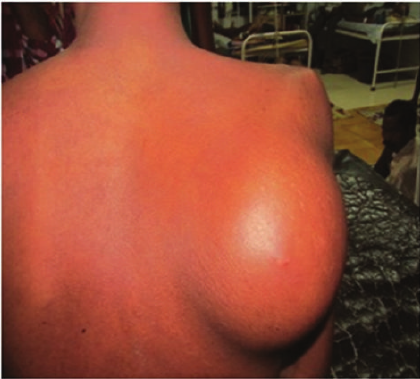
Figure 1: Clinical photograph of showing scapular swelling before chemotherapy.